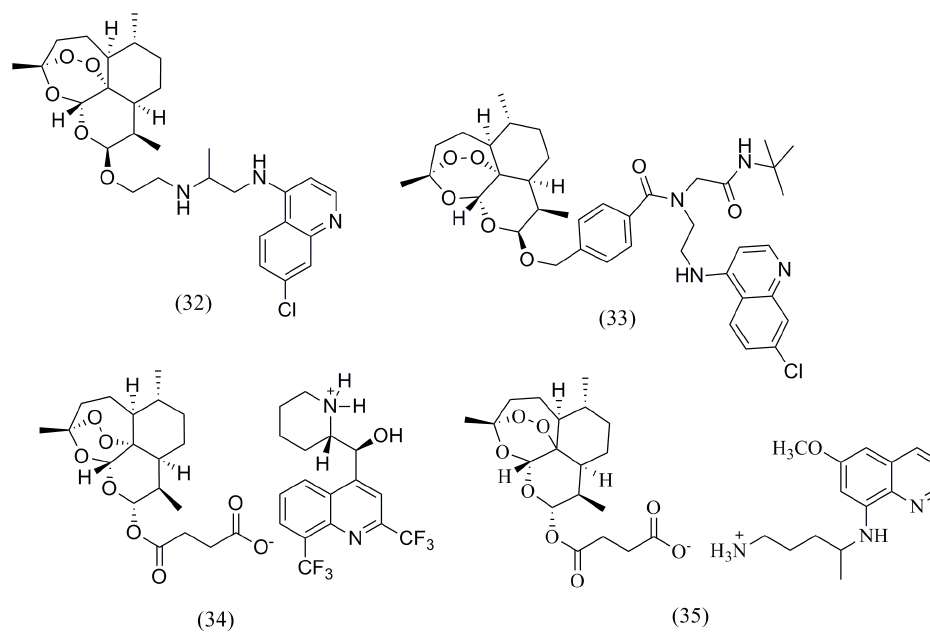
Figure 13 - Structures of ART hybrids 32-35